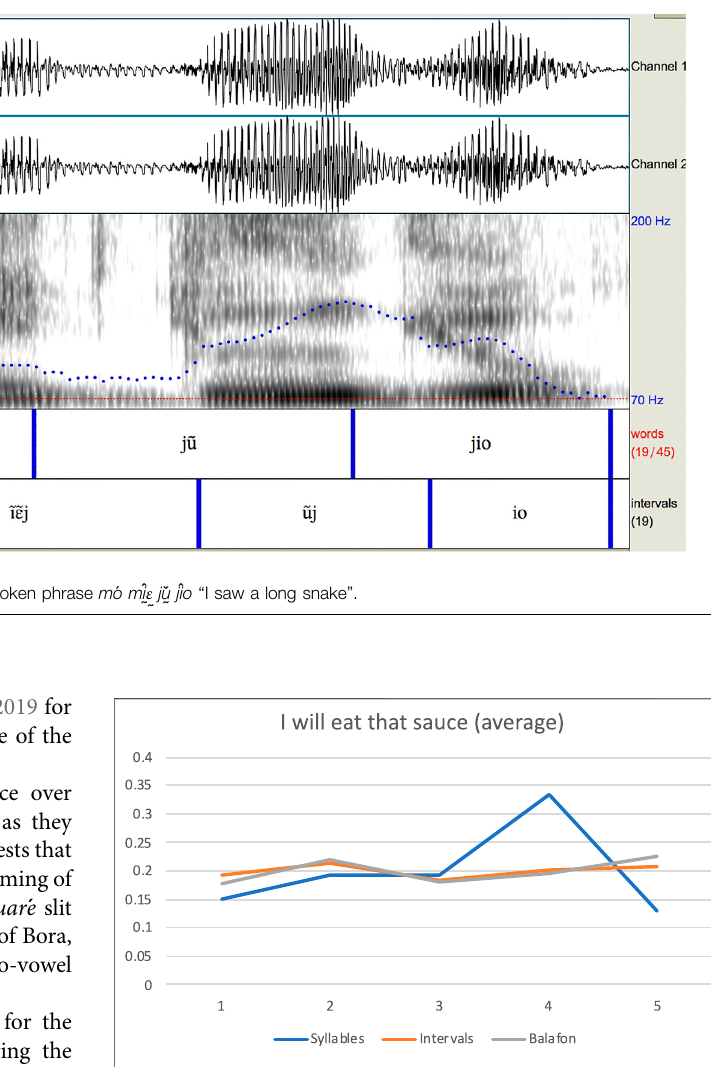
FIGURE6 | Relative timing of fi rst fi ve words of mo ́ na ̌ k ʊ ́ na ̏ n b ε ́ n ɔ ̏ “ Iwill eat that sauce ” , averaged across three spoken and played